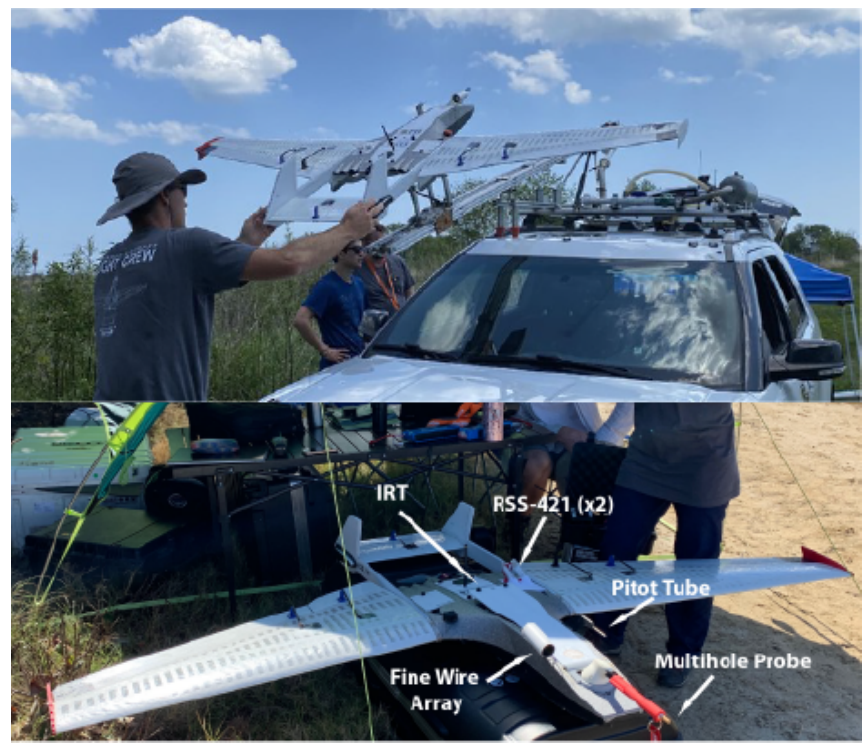
Figure 1. The University of Colorado RAAVEN being prepared for launch during WiscoDISCO21 (top) and a closeup of the RAAVEN sensing systems